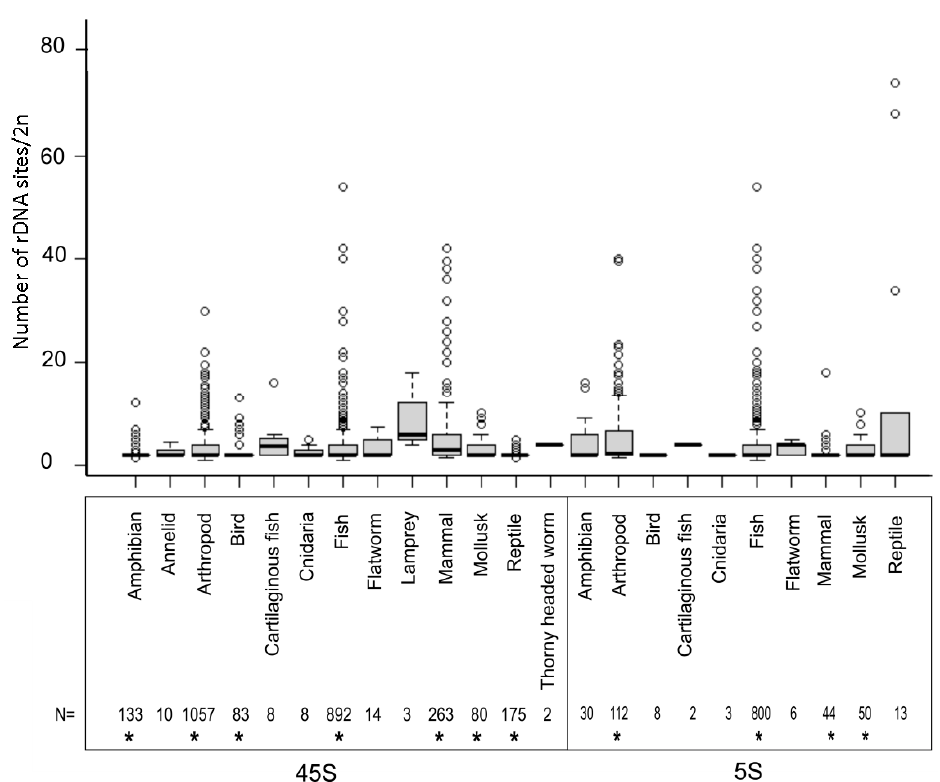
Figure 2. Number of 45S and 5S rDNA sites per diploid cell in different animal groups. The sample size is shown below the diagram. Boxes represent Q1, median, Q3. Outliers marked by circles were calculated from the interquartile range (IQR): < Q1 − 1.5 × IQR and > Q3 + 1.5 × IQR. Asterisks (*) below the numbers mark groups in which statistical tests were carried out (Table S1).